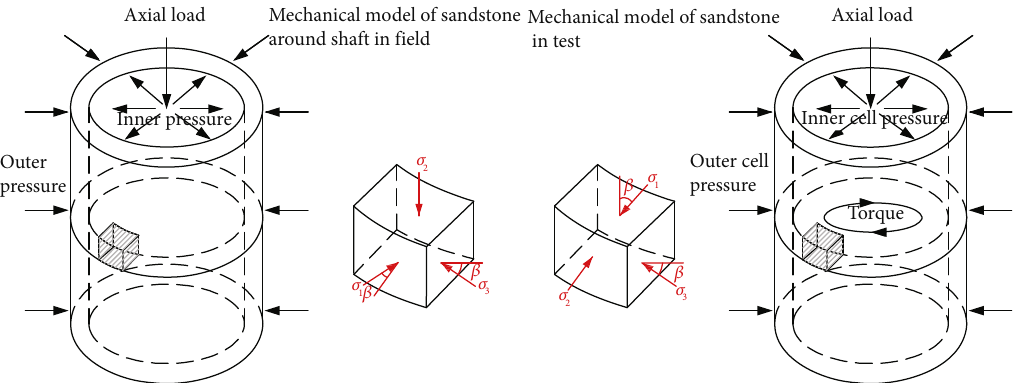
Figure 18: Mechanical model of sandstone around shaft in fi eld and in laboratory